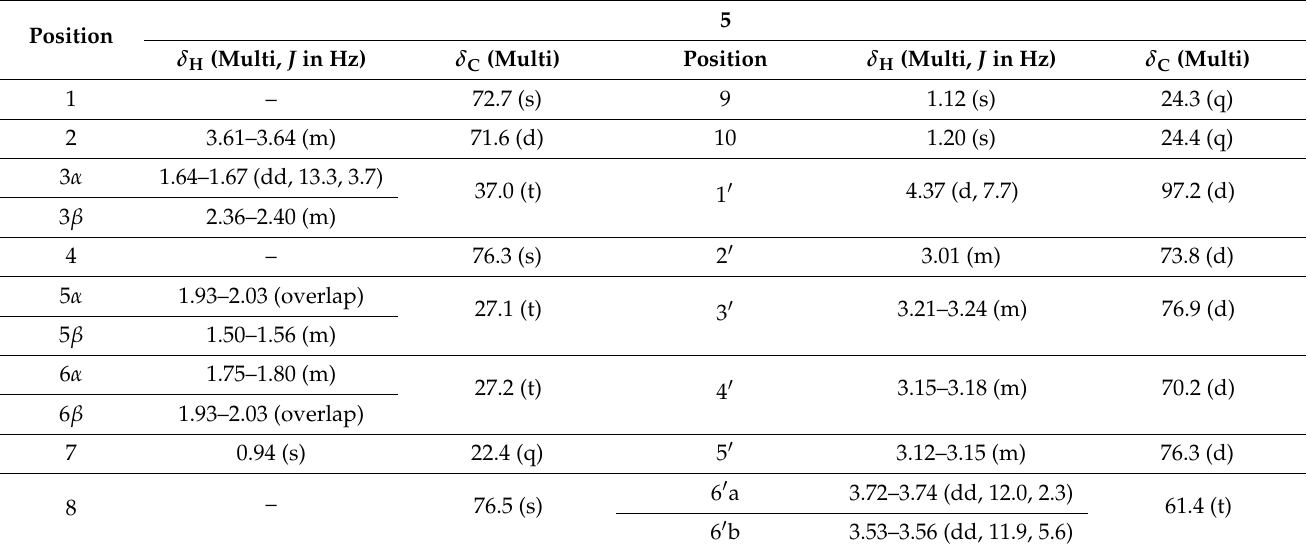
Table 2. 1 H NMR and 13 C NMR spectroscopic data of compound 5 in CD 3 OD.